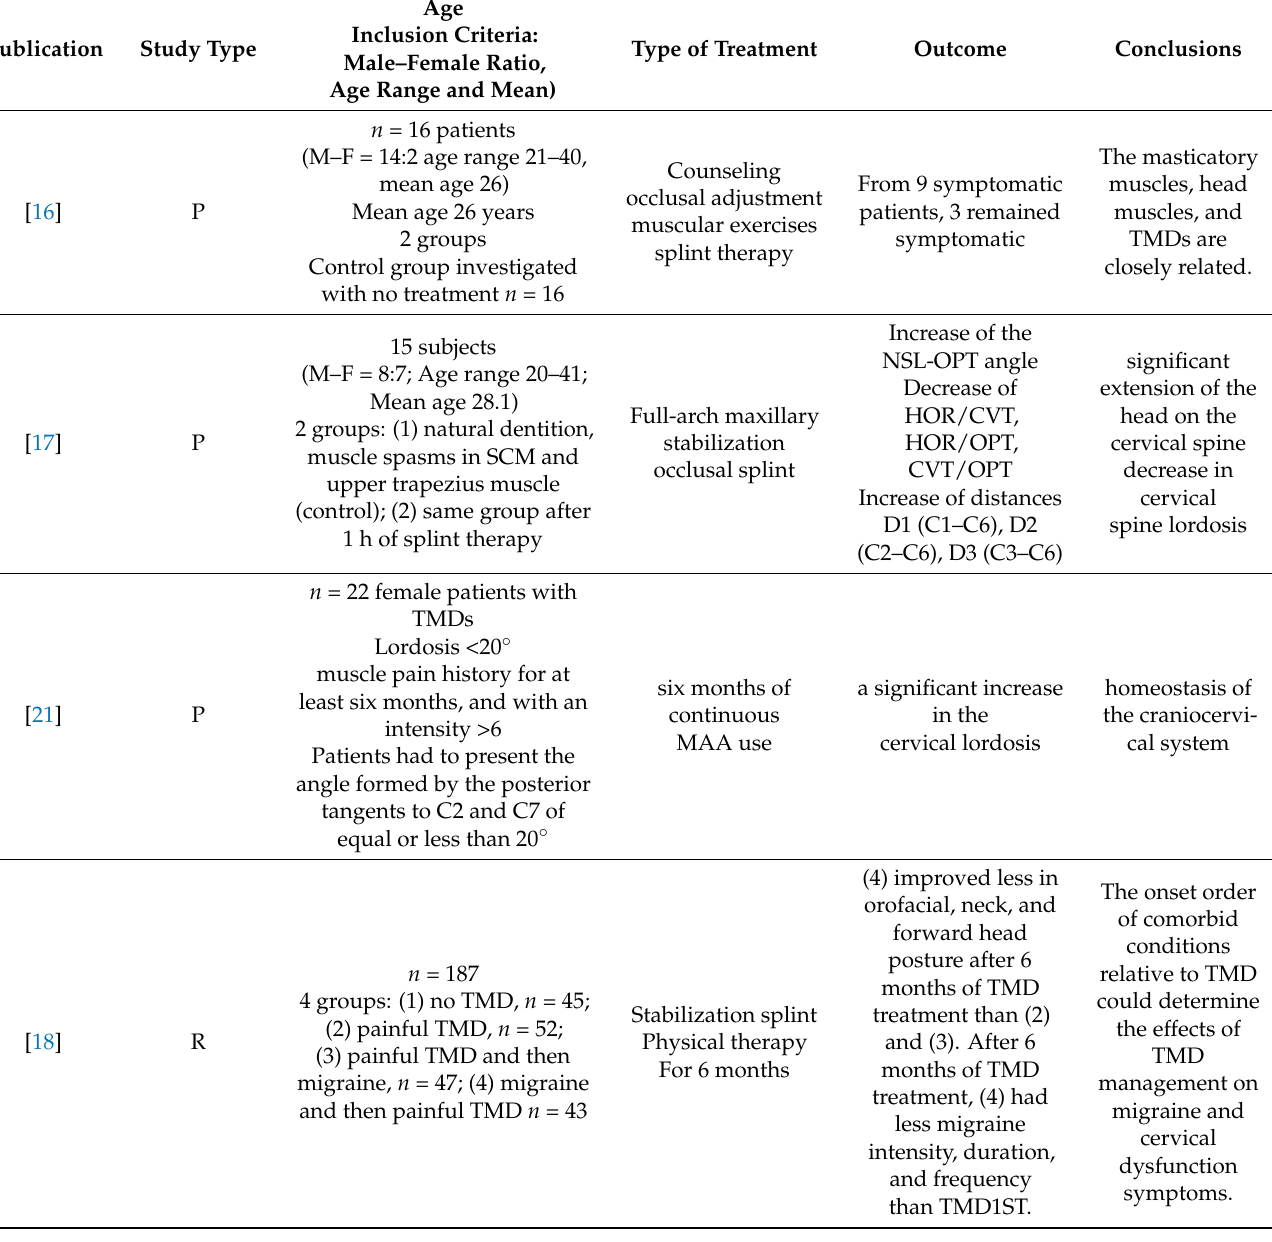
Table 1. Summary of included studies with assessment of